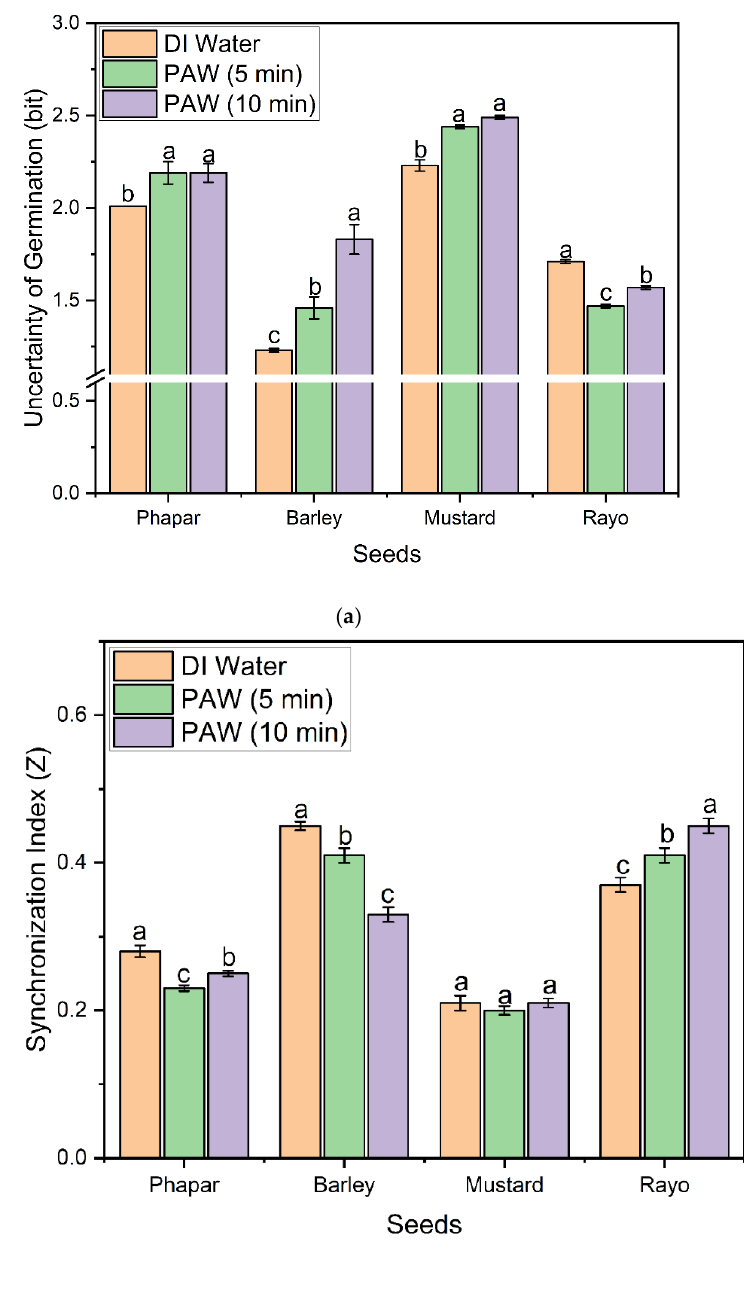
Figure 9. Effect of DI and PAW on the germination index (GI) of seeds. Different letters (a – c) indi- cate significant differences at p < 0.05 level among all treatments as determined by Tukey's multi- ple comparison test.